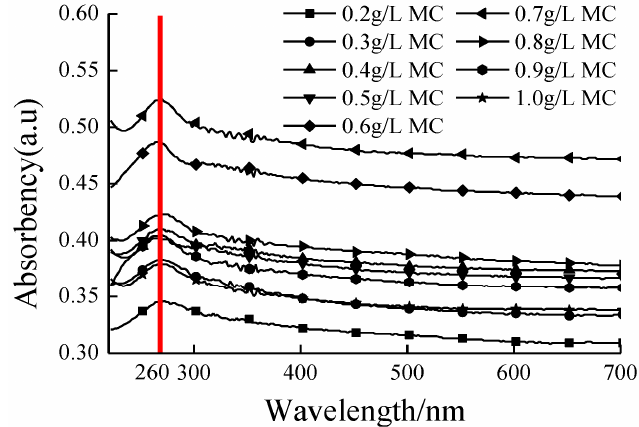
Figure 8. UV-Vis spectroscopy absorbance range of GNPs suspension with different MC amounts. Reproduced with permission from [33], MDPI, 2016.